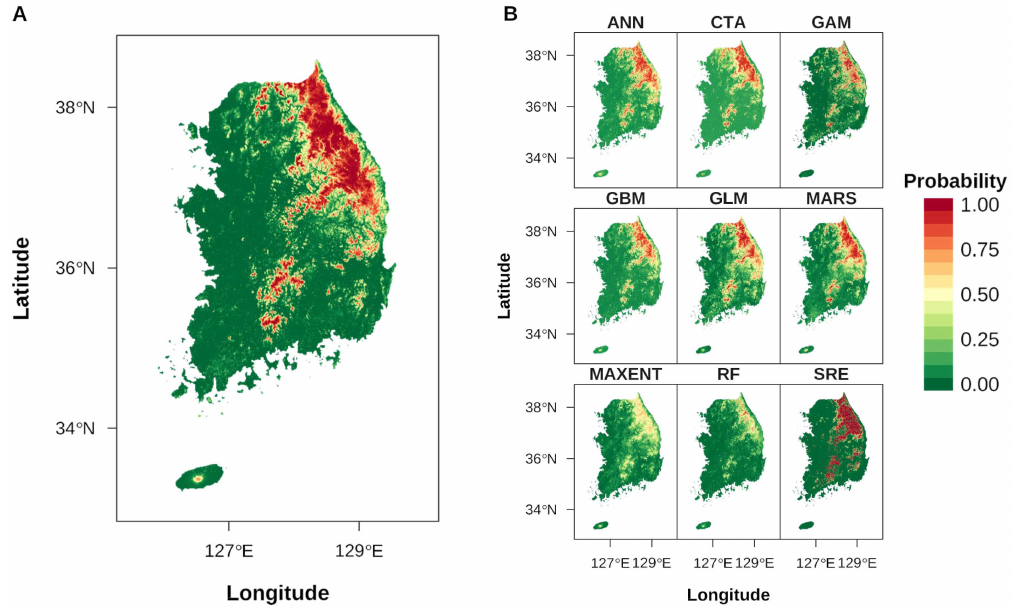
Figure 3. Habitat suitability for Angelica gigas predicted by the ( A ) committee averaging ensemble model and ( B ) single algorithm models under the baseline climate conditions